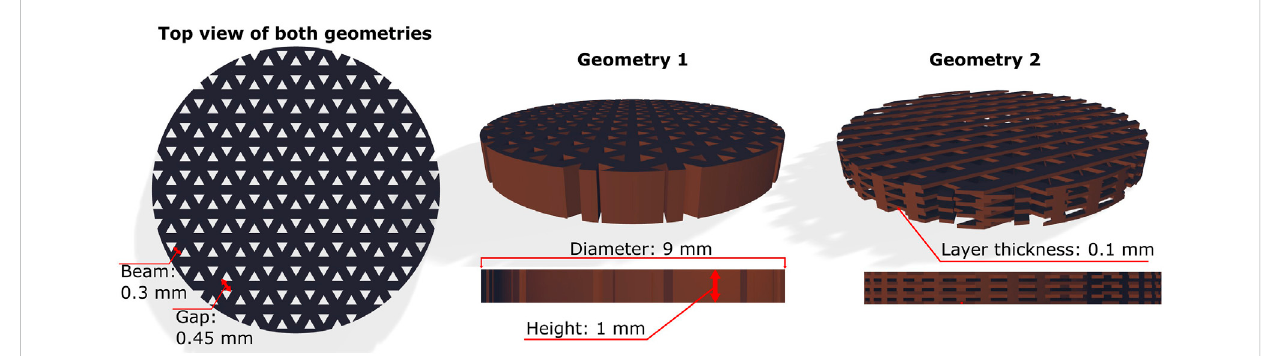
FIGURE 2 The geometries of the 3D scaffolds used in the study. The design of Geometry 1 can be described as 2.5D because the pattern does not change on the z -axis. The scaffolds of Geometry 2 represent different orientations of the superimposed printed beams in the z -axis.